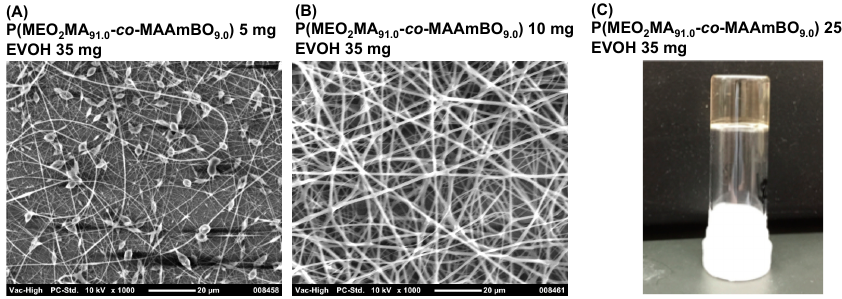
Figure 3. SEM image of electro-spinning samples of EVOH (35 mg) and ( A ) P(MEO 2 MA 91.0 - co -MAAmBO 9.0 ) (5 mg) and ( B ) P(MEO 2 MA 91.0 - co -MAAmBO 9.0 ) (10 mg) in 1 mL 1,1,1,3,3,3-hexafluoroisopropanol (HFIP). ( C ) Gel formation of EVOH (35 mg) and P(MEO 2 MA 91.0 - co -MAAmBO 9.0 ) (25 mg) in 1 mL HFIP.